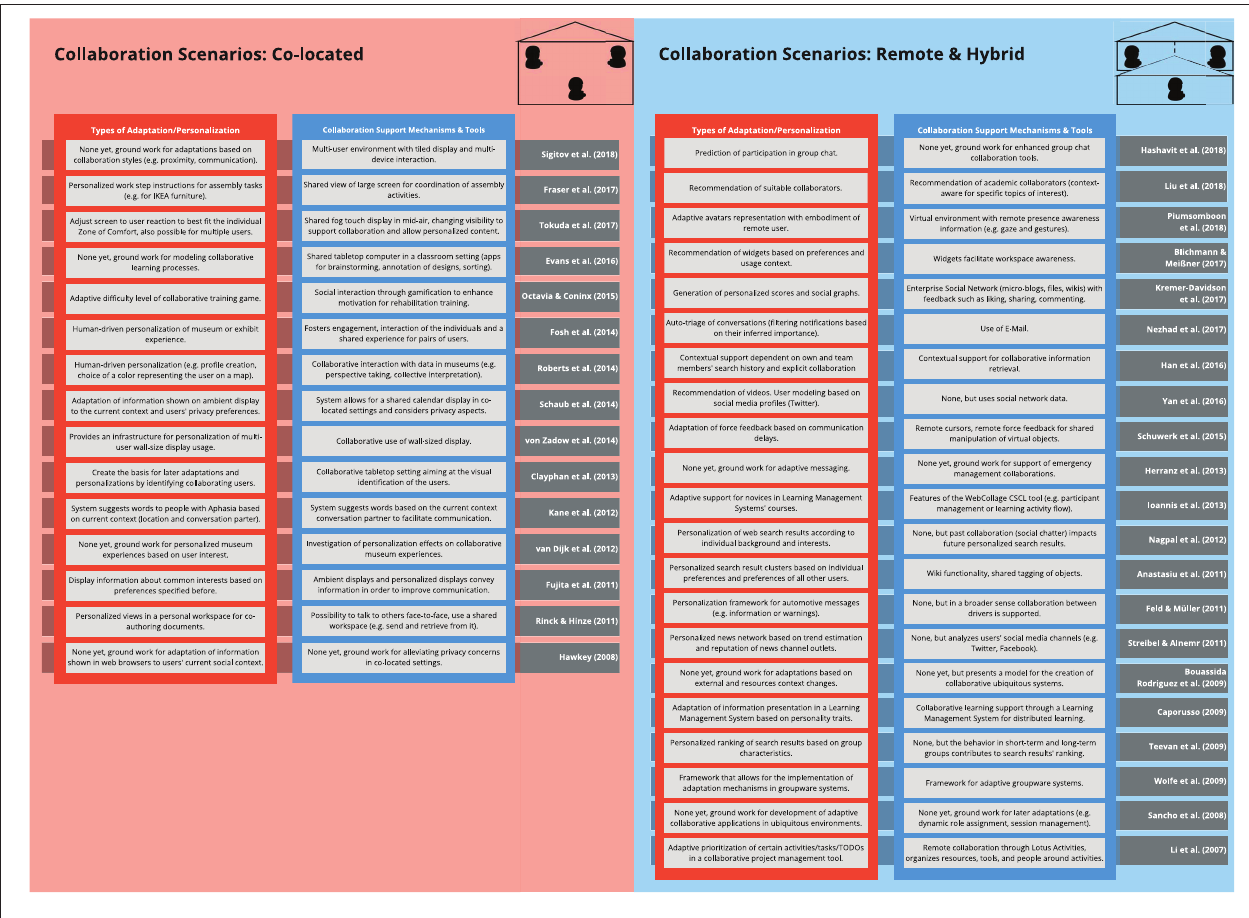
FIGURE 6 | The taxonomy of personalized collaborative